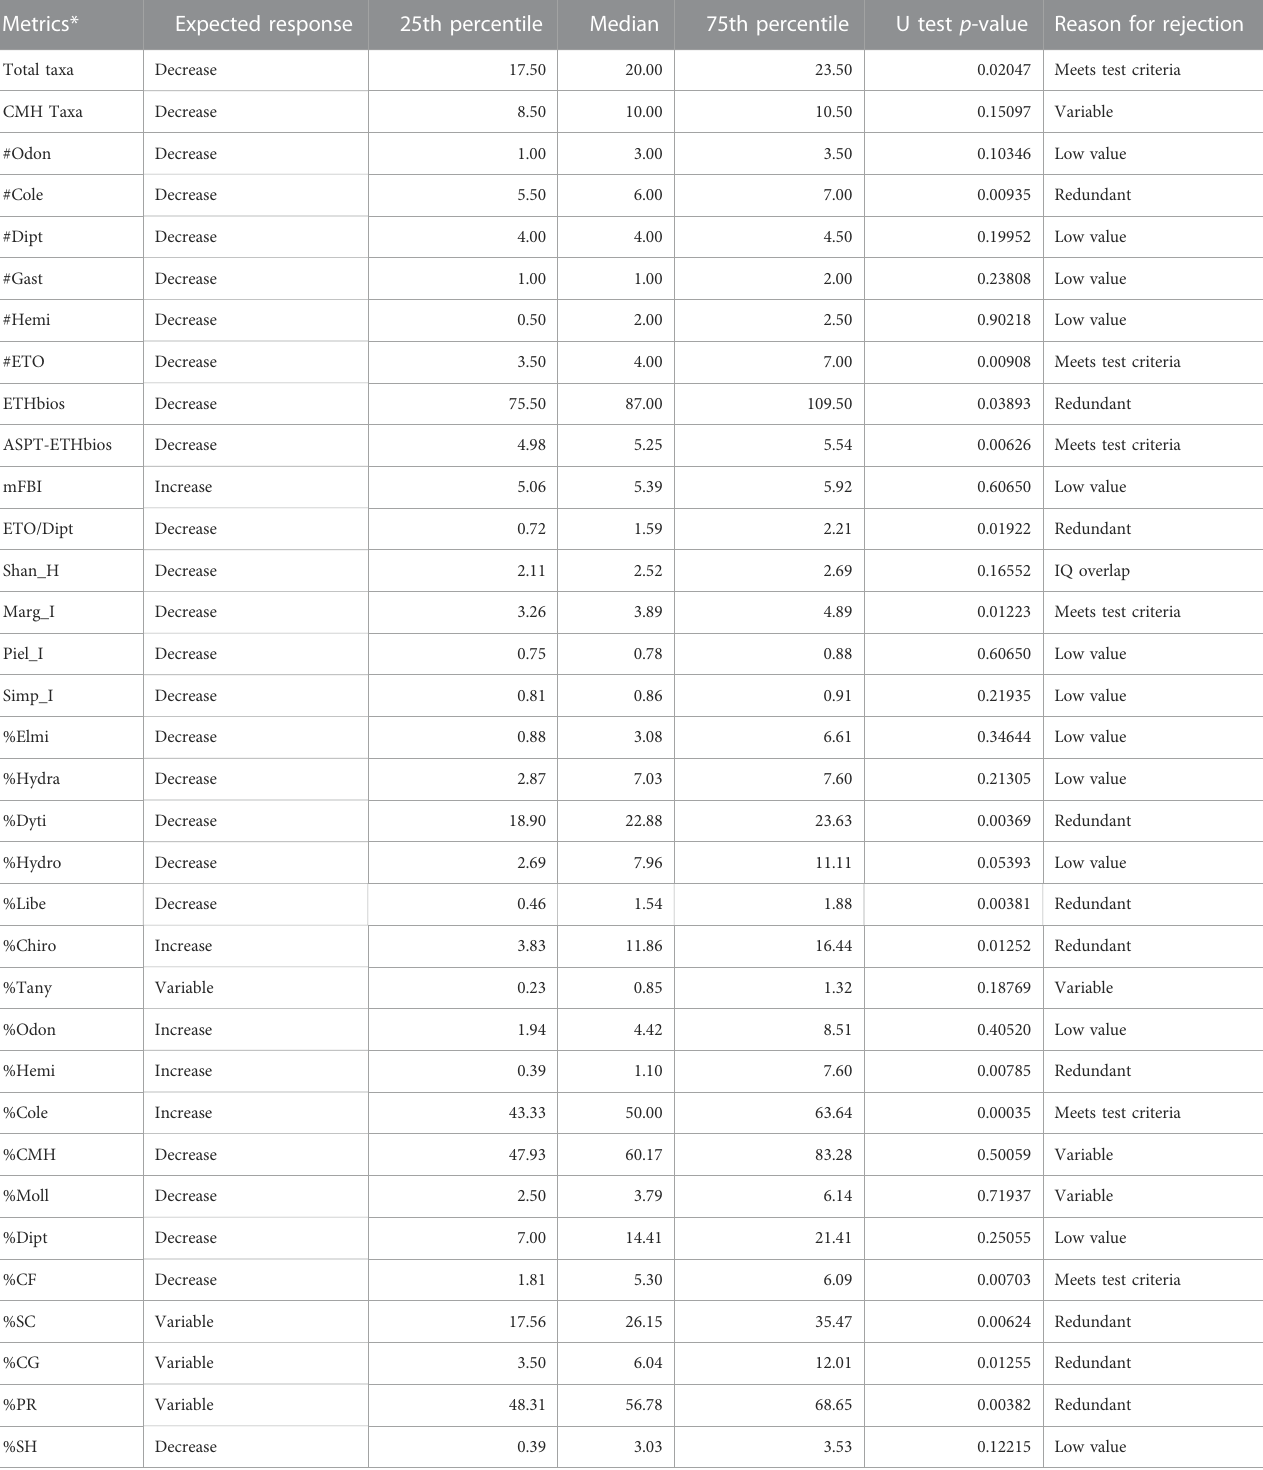
TABLE 2 The 34-candidate metrics passed the range test and core metrics selected for the MMI development in the reference sites with their interquartile values (25th percentile, median and 75th percentile).